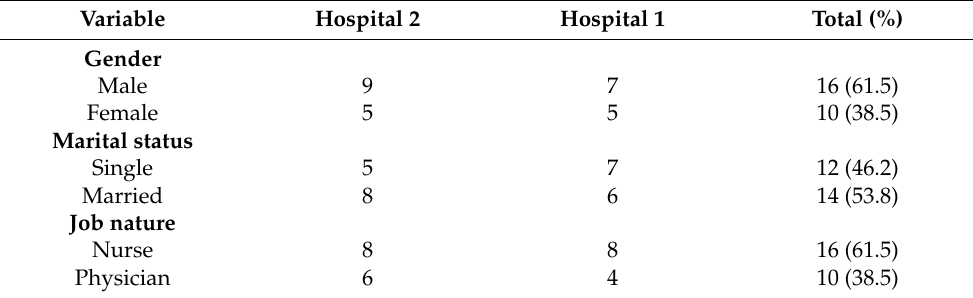
Table 2. Demographic Characteristics of Participants (n =